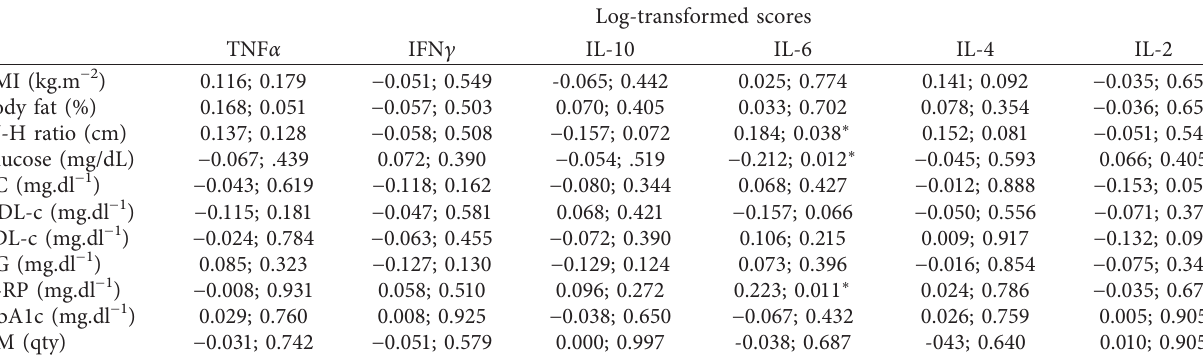
Table 2: Correlation analysis of the immune mediators with anthropometric and metabolic characteristics in a whole-group approach ( n �